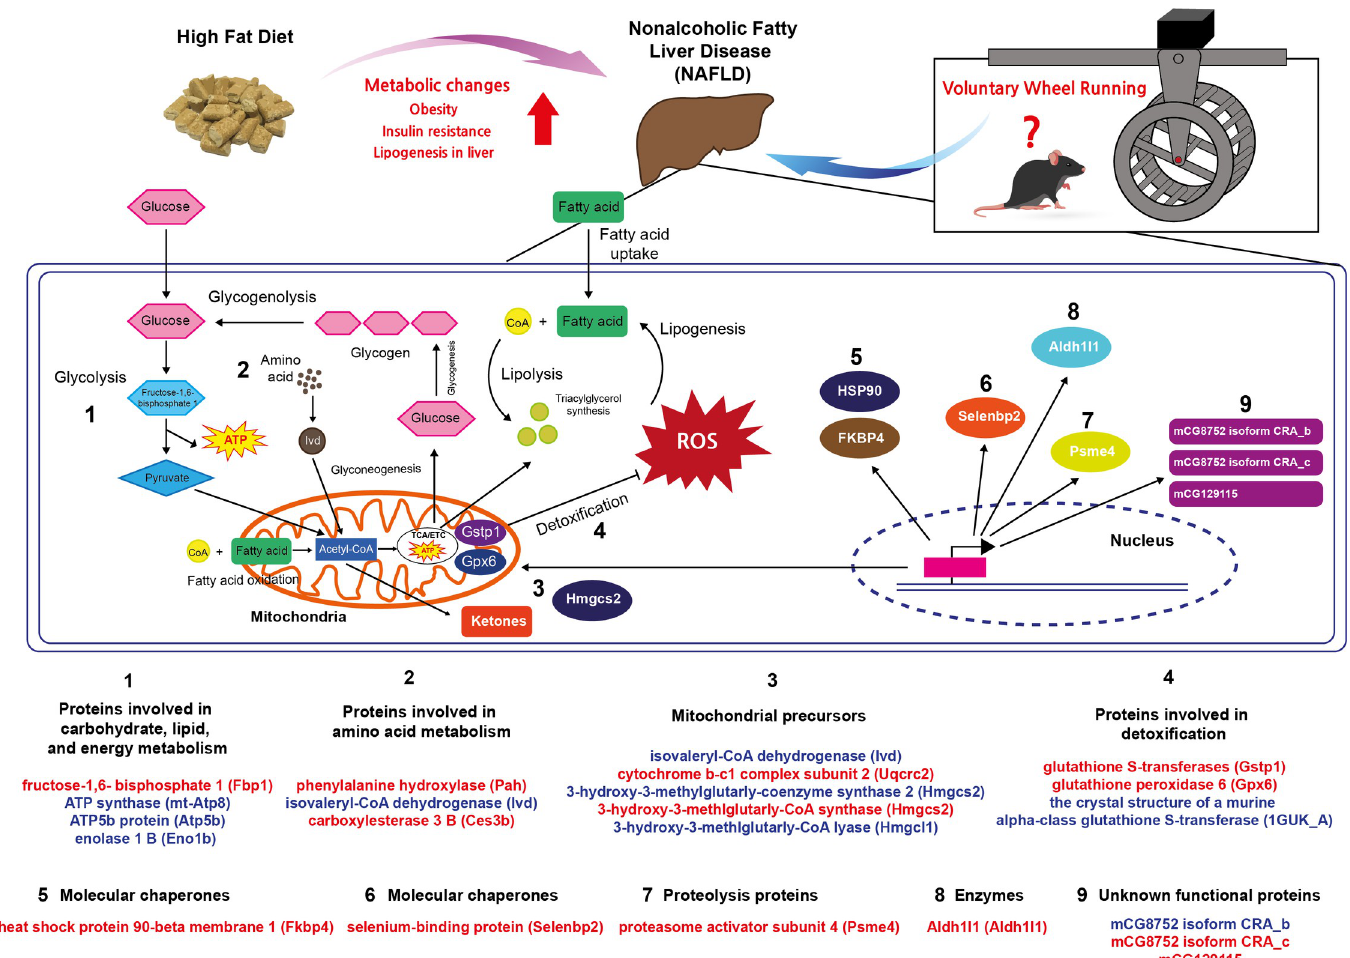
Fig 6. Summary of differentially expressed liver proteins from a high-fat diet and 12 weeks of voluntary wheel running intervention. Interpretation of proteomic analysis results by LC-MS/MS based on enriched functional annotation of proteins present at higher or lower levels in HFX compared to HFD. Proteins were grouped according to their functional properties into nine categories, as shown in the figure. ATP, adenosine triphosphate; TCA, tricarboxylic acid cycle; ETC, electron transport chain; ROS, reactive oxygen species; CoA, coenzyme A. Red color denotes upregulated protein expression in the HFX group compared to the HFD group and blue color indicates downregulated protein expression in the HFD group compared to the CON